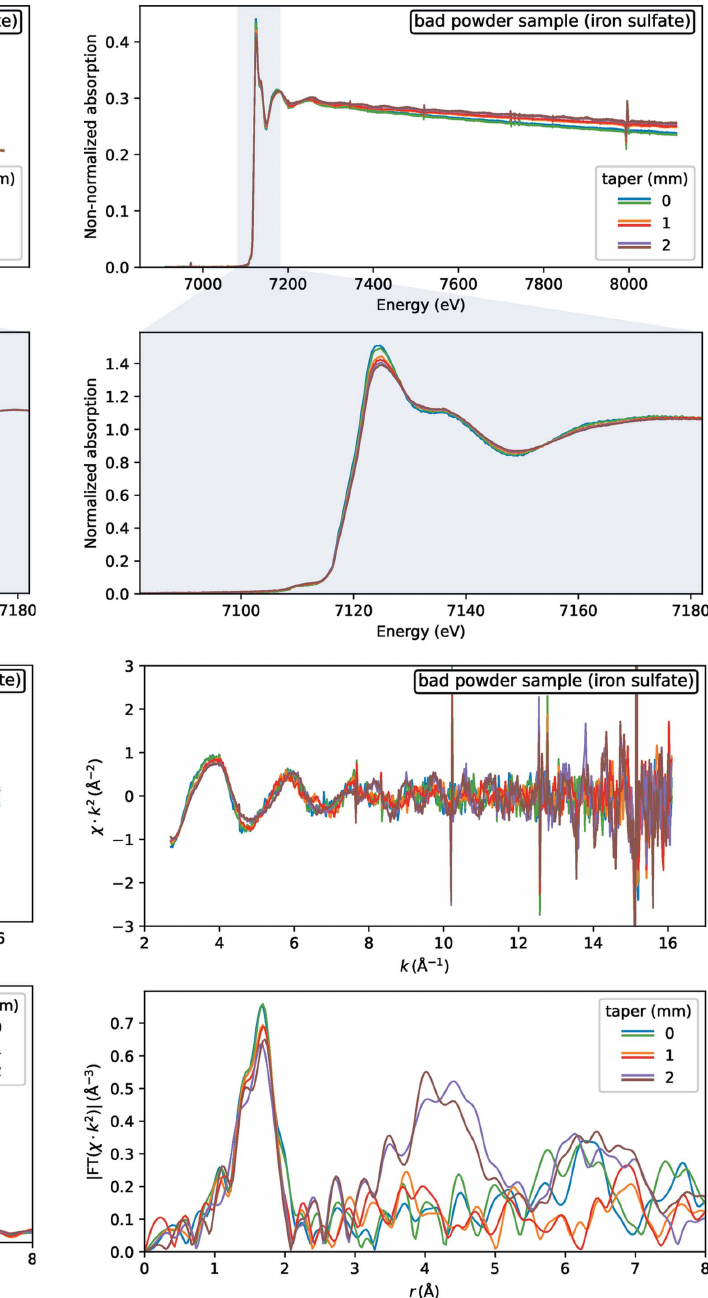
Figure 10 EXAFS spectra for a sample with an inhomogeneous thickness: a low- quality pressed pellet. Three values of wiggler gap taper were tested, each with two repeats of EXAFS, six curves in total in each